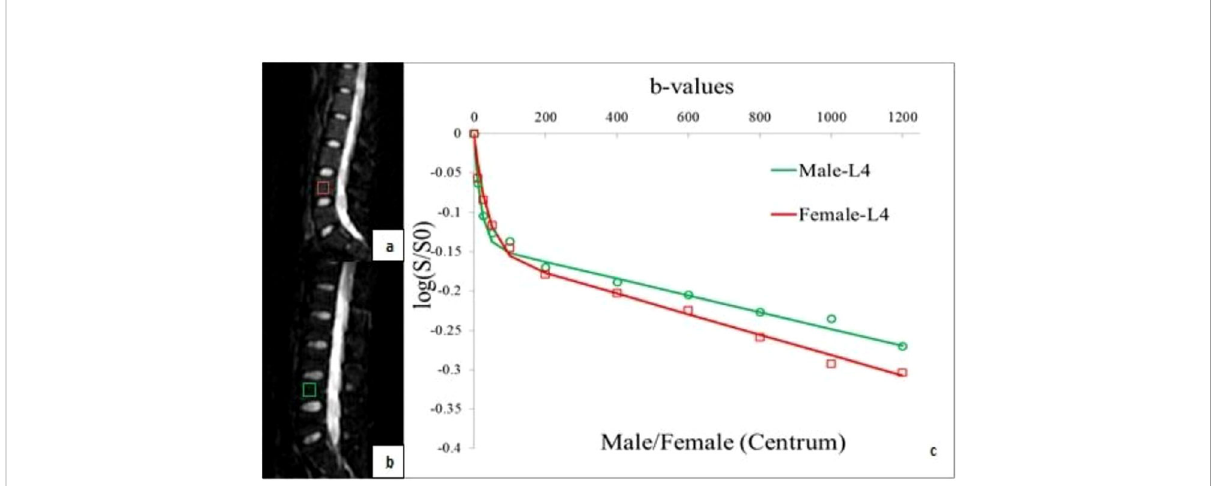
FIGURE 4 ROIs of the fourth vertebral bone marrow in a healthy 24-year-old woman (A) and in a healthy 24-year-old man (B) . The combination of their logarithmic plot of signal intensity decay and bi-exponential fi tting curves (C) , the signal intensity decays more quickly in men than that in women within b< 200 s/mm 2 . The bi-exponential fi tting curves for women (red line) and men (green line) are cross instead of